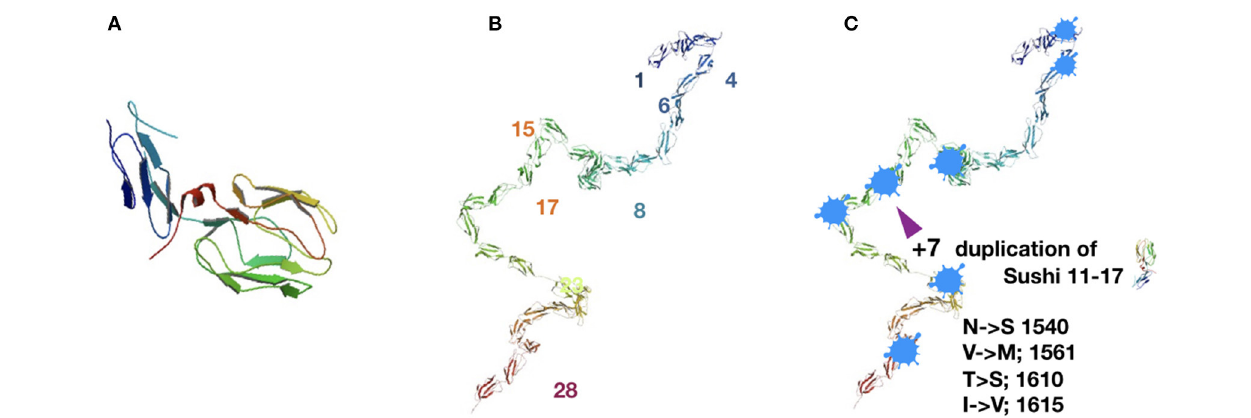
FIGURE 4 | Complement receptor 1 biology with the basic Sushi subunit domain repeat and major and minor alleles of the gene. (A) Single Sushi domain composed of ∼ 60 amino acids in beta sheet array, two stranded beta sheet facing three strand beta sheet, anti-parallel alignment. Major allele (left) in 83% of the population. Structure is an extracellular domain of 30 consecutive Sushi domains. Structure PDB 2Q7S, from the laboratory of SJ Perkins at UCL (Furtado et al., 2008). (B) Minor allele (right) in 11% of the population. The transmembrane domain (not shown) and basic Sushi domain subunit are unchanged. There is a seven Sushi repeat of Sushi domains 11–17, that is located directly adjacent to the original location of the duplicated Sushi domains. The binding site for C3b is located at domains 15–17, so this repeated segment of Sushi domains 11–17 includes a second binding site for C3b. (C) Inkblot; regions of predicted intrinsic disorder within the CR1 amino acid sequence. These are short regions of amino acid repeats or regions mixed with charged amino acids and hydrophobic amino acids in close proximity that create ambiguity about preference for hydrophilic environment or hydrophobic surroundings instead. Prediction programs used were: PONDR developed by Romero, Li, Dunker, Obradovic and Garner, www.pondr.com, described in Xue et al. (2010). IUPRED, www.iupred2a.elite.hu, described in Dosztányi et al.